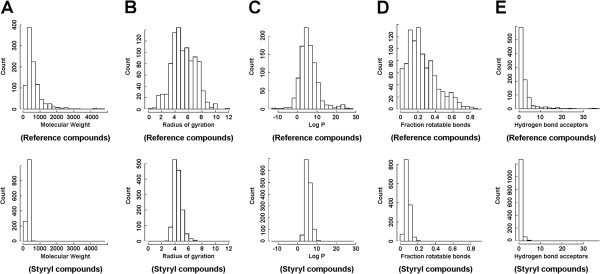
Histogram plots comparing the calculated physicochemical properties of a reference dataset of compounds with known subcellular localization features (top row) in relation to the library of 1,344 styryl molecules analyzed in this study (bottom row). A) Molecular weight; B) Radius of gyration; C) Logarithm of the octanol:water partition coefficients (logP); D) Fraction of rotatable bonds; E) Number of hydrogen bond acceptors.